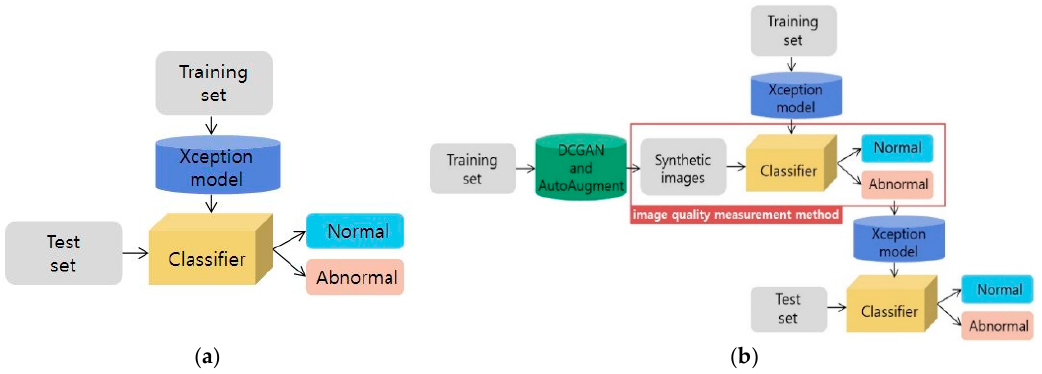
Figure 9. Structure of the gastroscopy image classification model: ( a ) original and ( b ) DCGAN and 25 augmentation policies of the CIFAR-10 dataset.